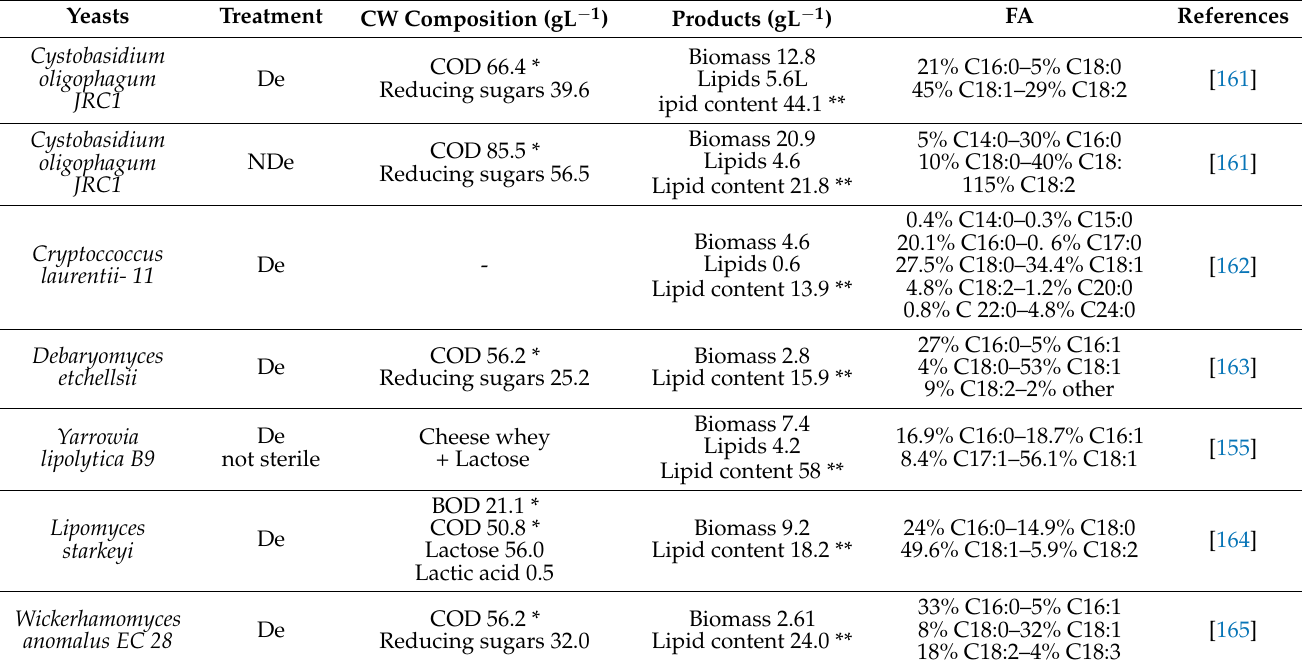
Table 4. Use of oleaginous yeasts on CW: effect on CW characteristics and products synthetized by yeasts metabolism. FA = fatty acid composition; De = Deproteinized; NDe = not Deproteinized. * = mgL -1 , ** = (%, w/w)